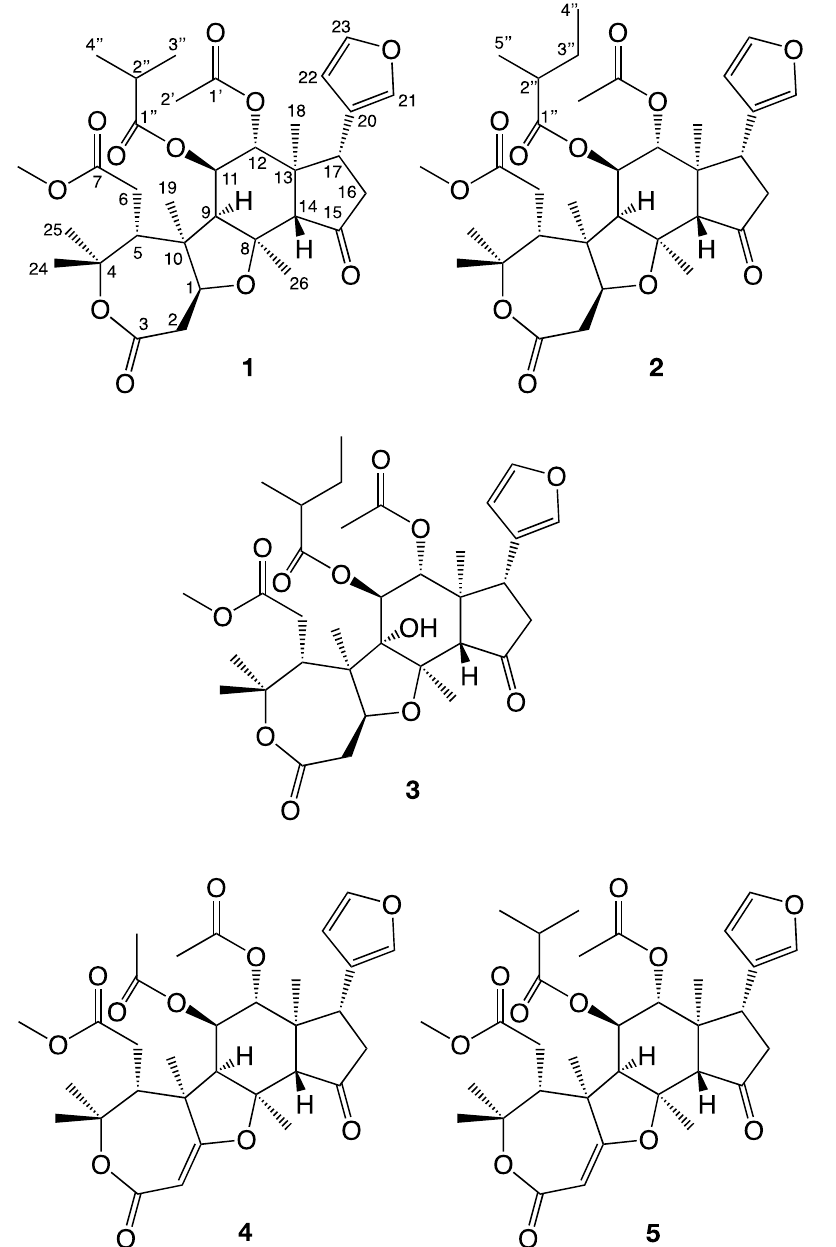
Figure 2. The new limonoids isolated from Trichilia adolfi in this investigation. In a recent study by us, the four novel limonoids trichilianone A–D were isolated from the bark of Trichilia adolfi [21]. The structures of the trichilianones appear related to the hortiolide-type limonoids, with five fused rings. An ε -lactone is attached to a tetrahydrofuran ring that is connected to a bicyclo [5.1.0] hexane system, joined with a cyclopentanone containing a 3-furanyl substituent. Continuing our investigation of the constituents of T. adolfi , with the aim to characterize its antiparasitic metabolites, the present study is focused on the characterization of new metabolites present in the bark. The structures of the isolated metabolites were elucidated by spectroscopic analysis; HR-MS, and 1D and 2D NMR experiments (COSY, HMBC and NOESY correlations are summarized in Figures 3–5). The cytotoxicity of pure metabolites was evaluated in in vitro cell cultures of murine macrophages (Raw 264.7 cells), while the leishmanicidal properties were evaluated in the Leishmania amazoniensis and L. braziliensis